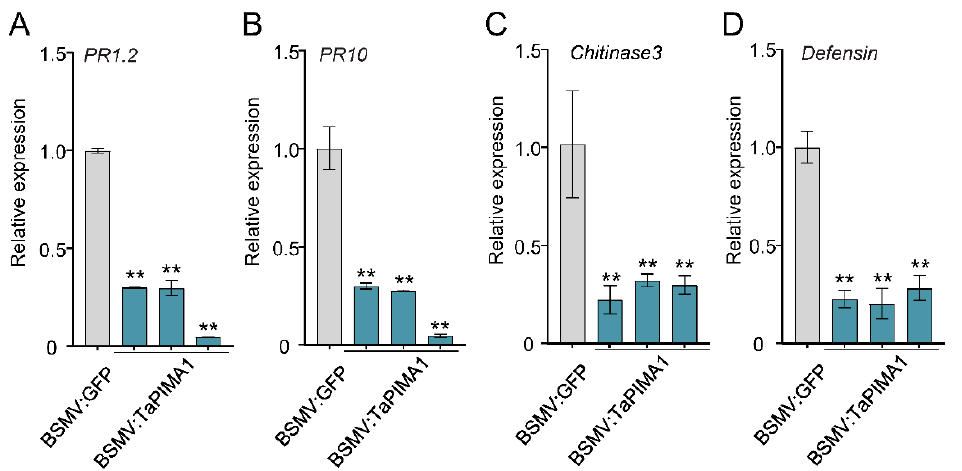
Figure 5. The expression levels of PR genes in TaPIMA1 -silenced CI12633 plants at 10 dpi with R. cerealis . The PR-1.2 ( A , GenBank accession no. AJ007349), PR10 ( B , GenBank accession no. CA613496), chitinase3 ( C , GenBank accession no. LOC542780), and defensin ( D , GenBank accession no. CA630387), were regulated by TaPIMA1 . The significant differences determined by one-way ANOVA (** p < 0.01). TaActin was used as internal control. Error bars indicates standard deviation.